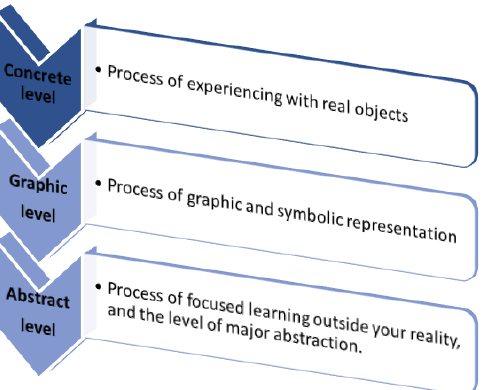
Figure 2. Educational Mechatronics Conceptual Framework: macro-process levels and processes involved in the construction of learning.